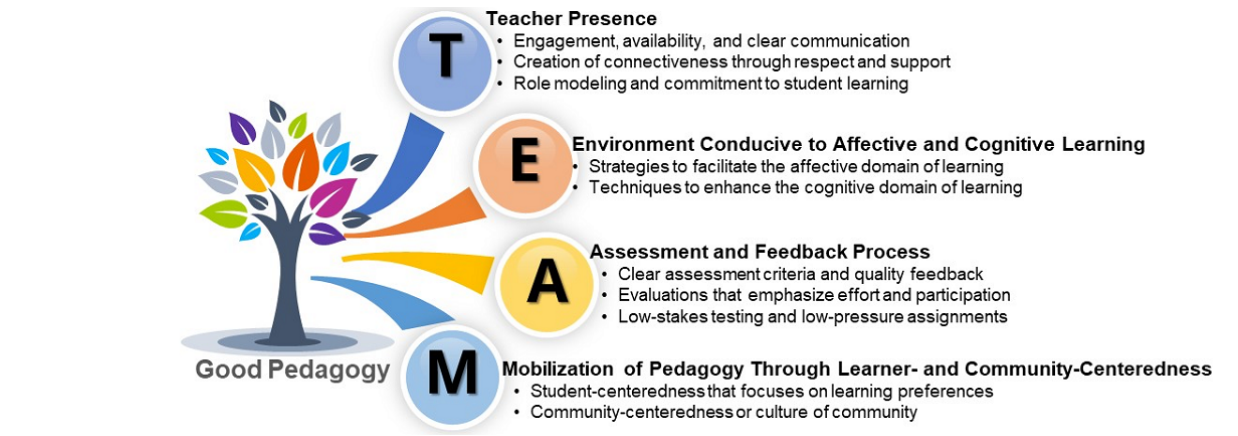
Figure 1. Overview of the key themes and their